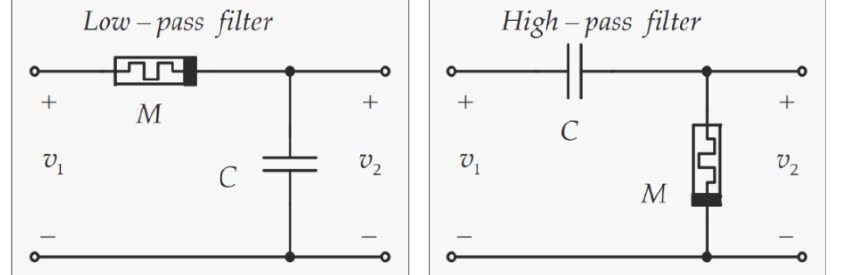
Figure 14. Low-pass and high-pass memristor-based filters. The capacitance of C has a value of 1 nF. In the low-pass filter, the capacitor C is connected to the output and shunts it for frequencies higher than the cut-off frequency f low [19,43]: M MC In the high-pass filter, the memristor M is connected in parallel to the output. The cut-off frequency of the high-pass filter is calculated by a formula similar to formula (11). The cut-off frequencies are changed by the alteration in the memristance M , using positive or negative external voltage pulses with levels that are higher than the memristor activation threshold v thr . In the considered low-pass and high-pass filters, the memristors operate with signals which have a lower level than their activation thresholds. Memristors behave as linear resistors with a constant value of their resistances. The amplitude-frequency and phase- frequency responses of the low-pass and high-pass filters are presented in Figure 15 for several different values of the memristances to represent the change in the respective cut-off frequencies and the frequency bands.